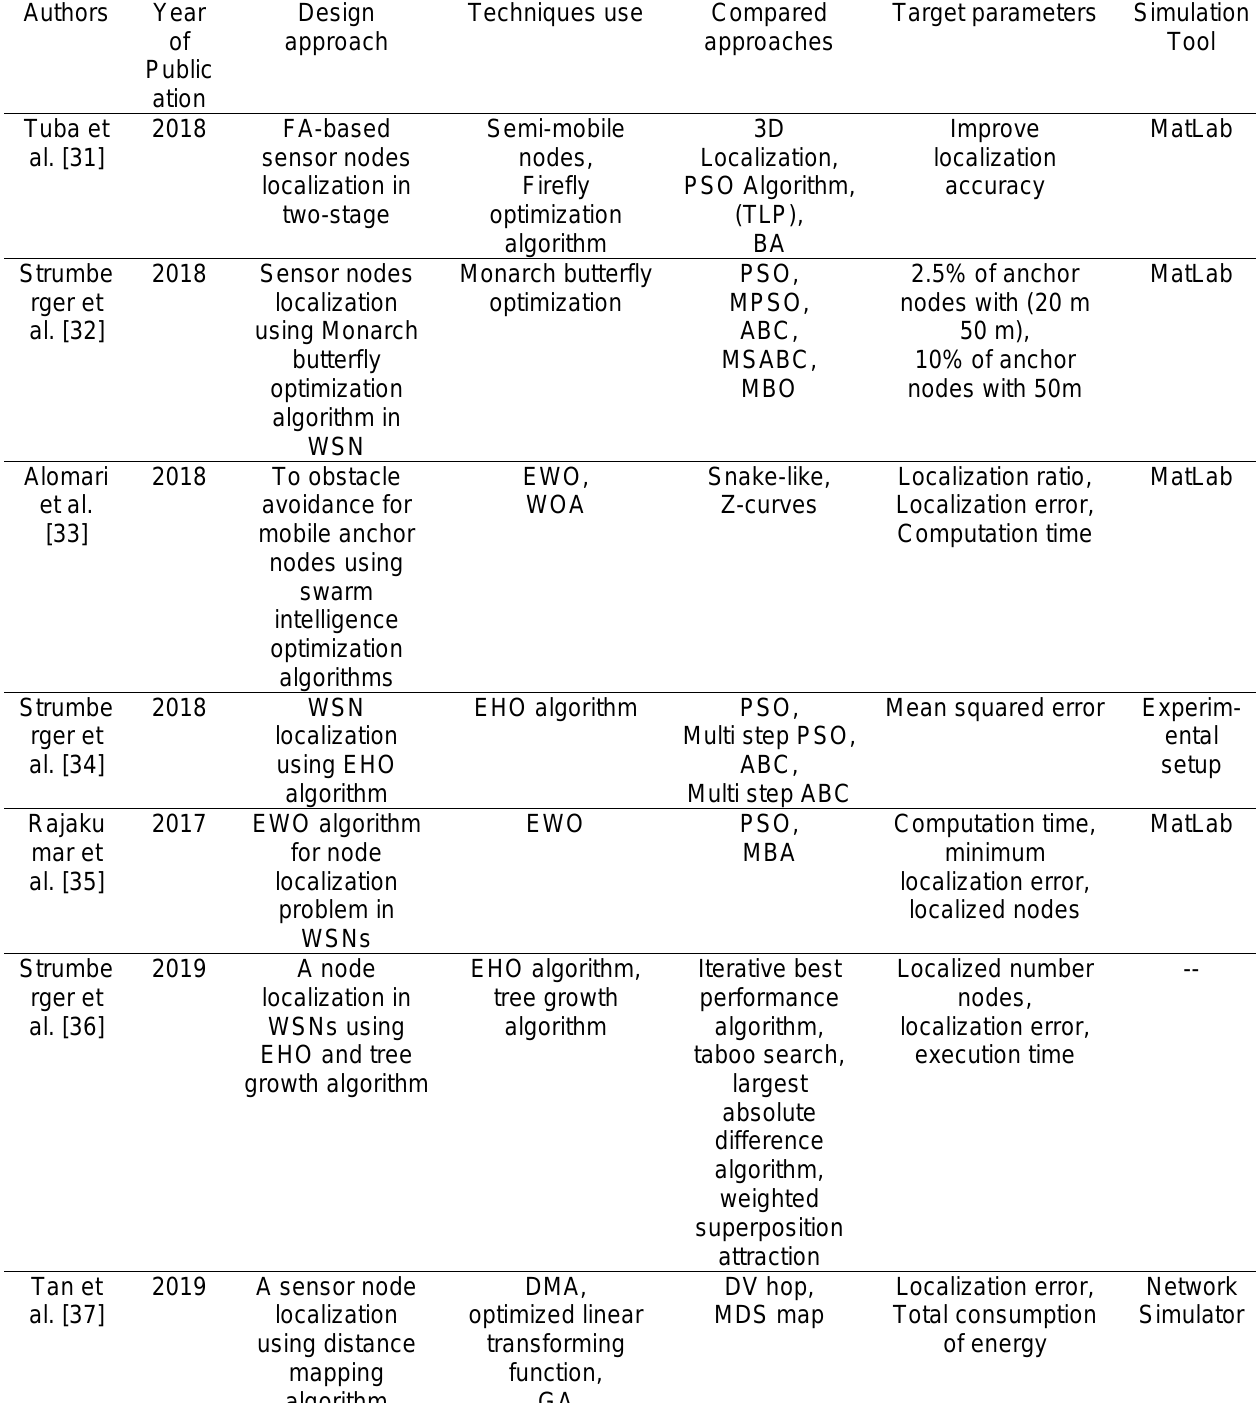
Table 3. Taxonomy of miscellaneous beacon-based localization approaches using computational intelligence algorithms sensor nodes in